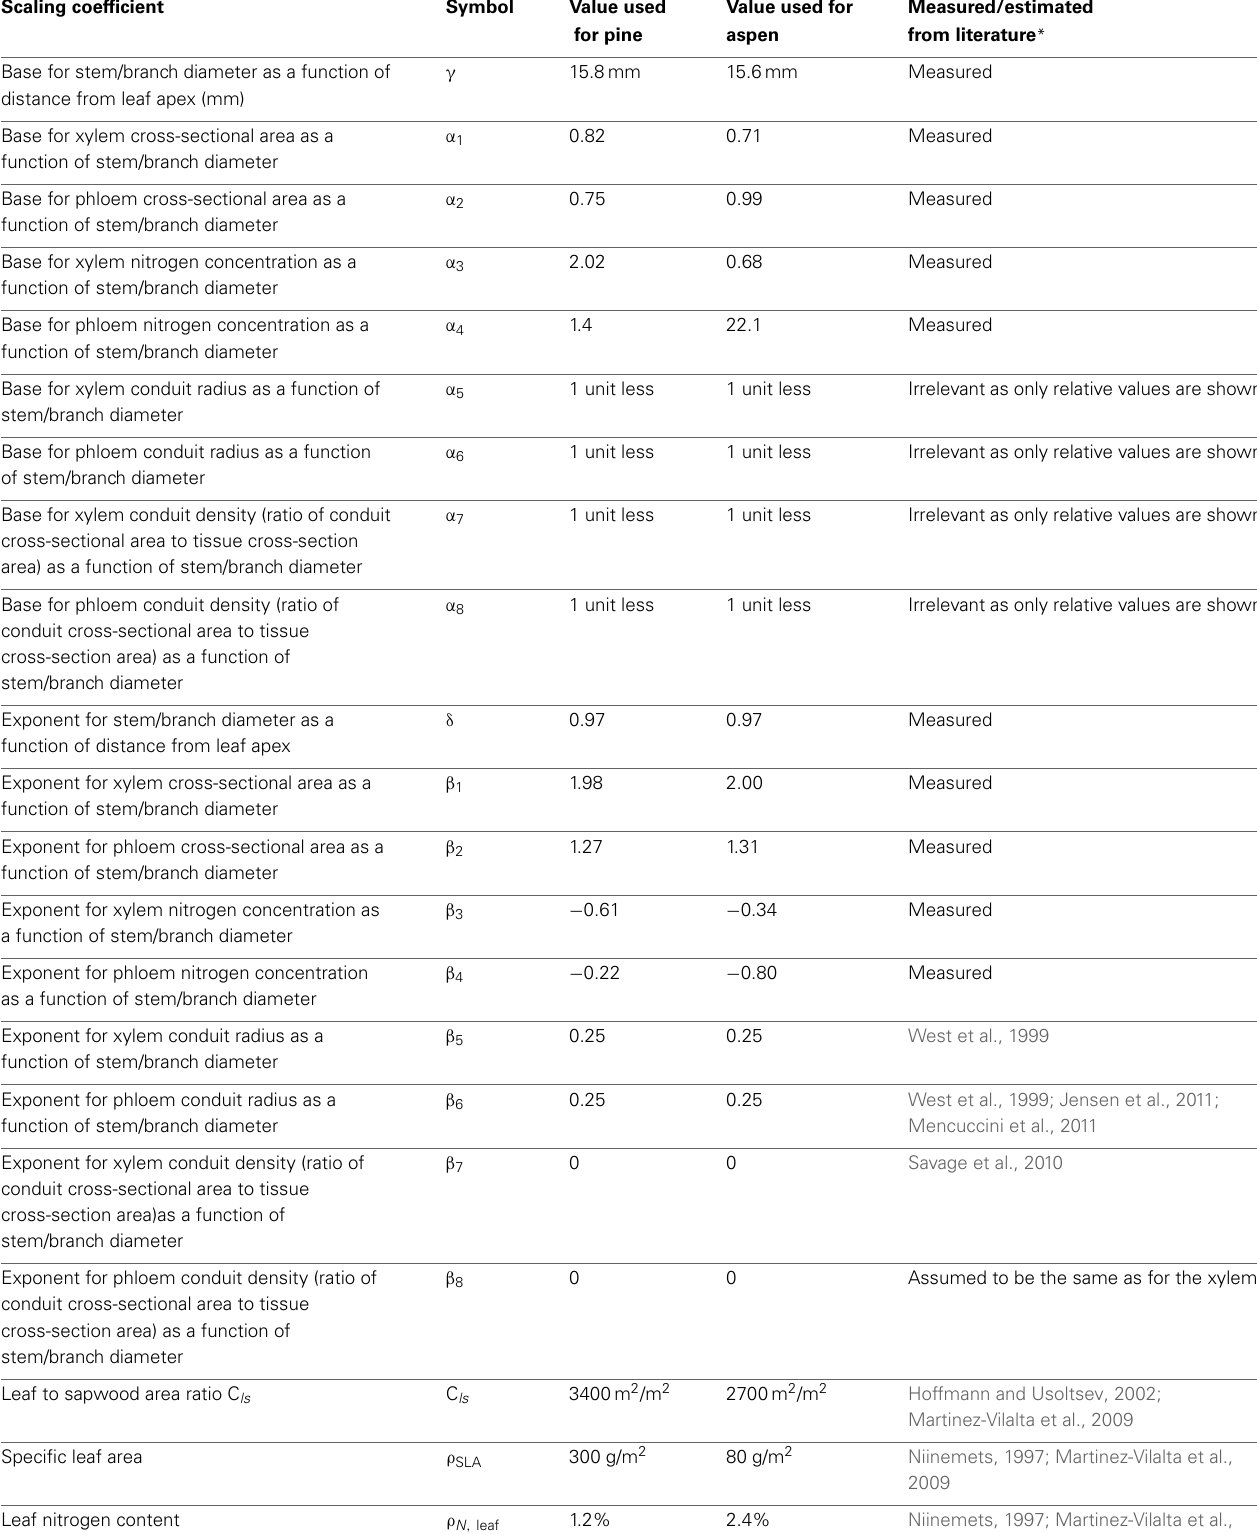
Table 3 | The scaling coefficients of xylem and phloem properties as a function of stem/branch diameter used in the scaling Equation (1). Scaling coefficient Symbol Value used Value used for for